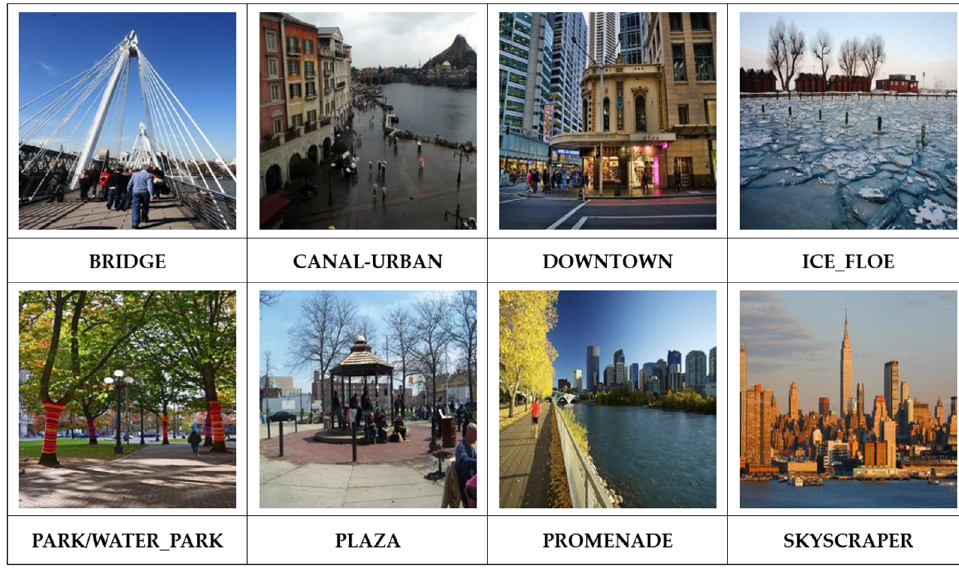
Figure 6. The predicted highest-proportion classifications in the Places365 database example.